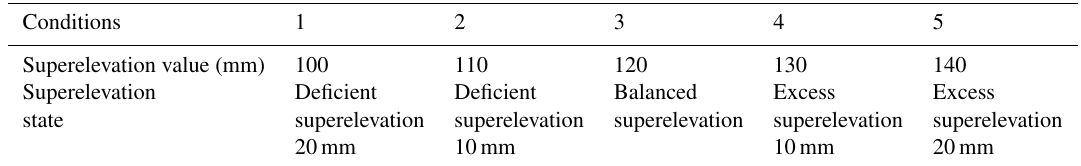
Table 4. Calculation conditions of different superelevation states.